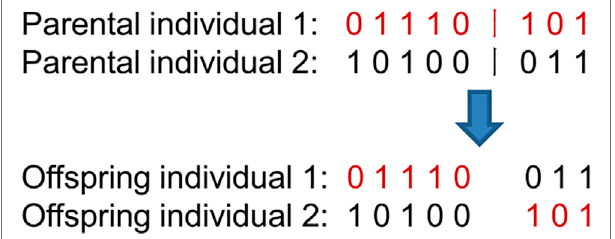
FIGURE 1 | Illustration of single-point